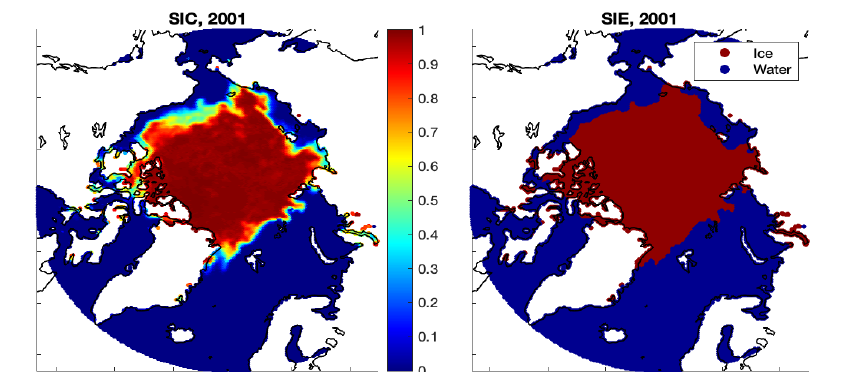
Figure 3. Left panel : The Arctic sea ice concentrations in September of 2001. Right panel : The corresponding binary Arctic SIE data in the same month. The spatial grid cells are displayed in a polar stereographic projection.